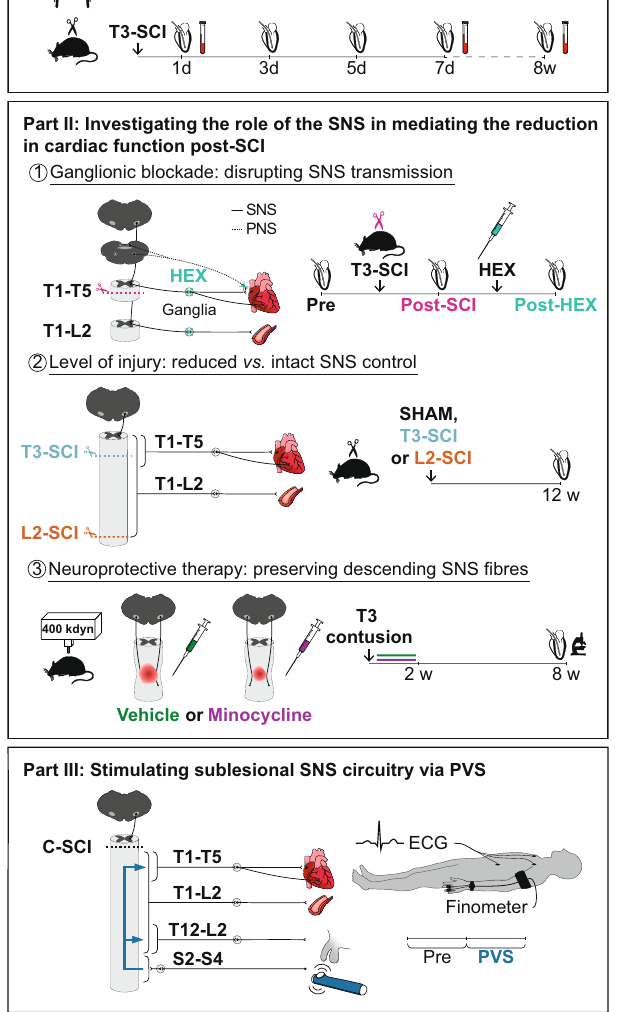
Fig. 1 Summary of aims and methods. C-SCI, cervical spinal cord injury; ECG, electrocardiogram; HEX, hexamethonium bromide; L2-SCI, L2 complete transection SCI; PNS, parasympathetic nervous system; PVS, penile vibrostimulation; SNS, sympathetic nervous system; T3-SCI, T3 complete transection